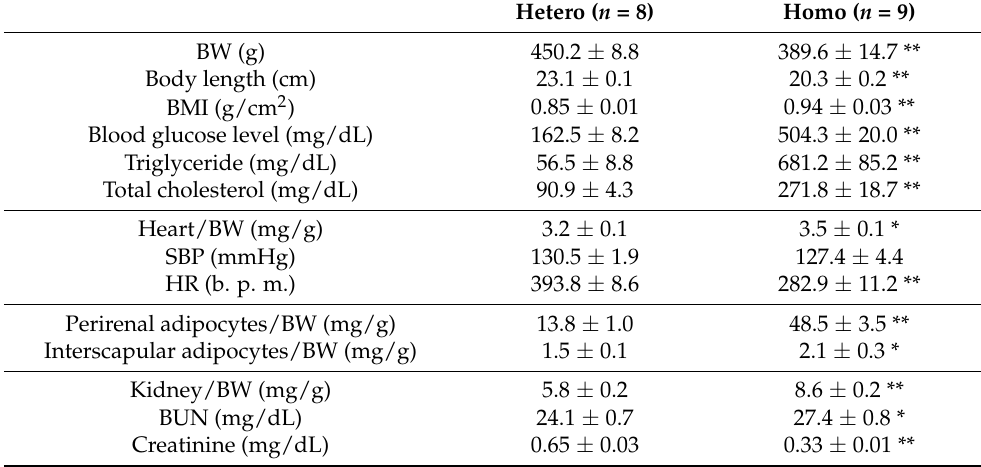
Table 1. Physical and biochemical parameters in Zucker fatty diabetes mellitus (ZFDM)-Lepr fa/+ (Hetero) and ZFDM-Lepr fa/fa (Homo) rats at 36–38 weeks old. BW: body weight, BMI: body mass index, SBP: systolic blood pressure, HR: heart rate, BUN: blood urea nitrogen. Results were expressed as means ± standard error of the mean (Hetero: n = 8, Homo: n = 9). * p < 0.05, ** p < 0.01 vs.